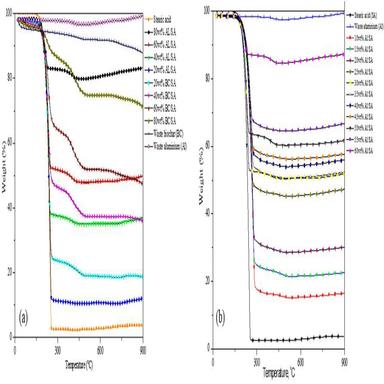
(a). TGA curves of stearic acid, carbon BC, recycle Al can powder and newly formulated waste C-PCMs ranging from 20 wt% until 80 wt% of C-PCMs (b) TGA curves of stearic acid, carbon BC, recycle Al can powder and newly formulated waste C-PCMs ranging from 20 wt% until 80 wt% of C-PCMs.